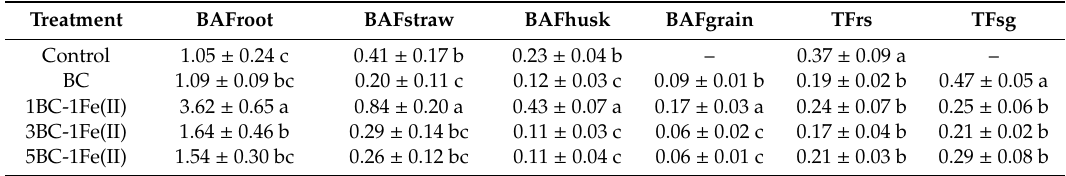
Table 3. Bioaccumulation factors (BF) and translocation factors (TF) of Cd.